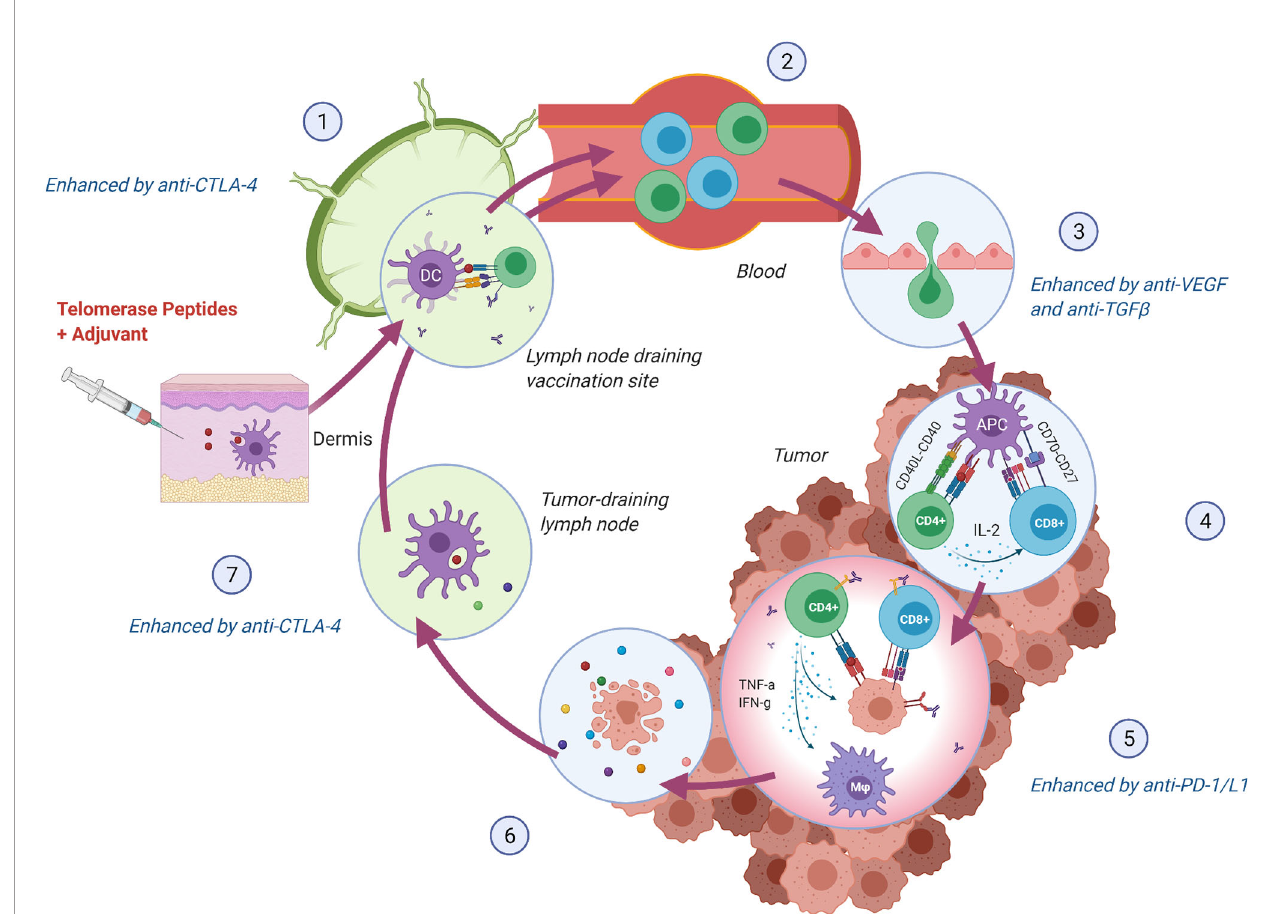
FIGURE 2 | hTERT speci fi c CD4+ Th1 cells support crucial steps in the Cancer Immunity Cycle (51). (1) Vaccine peptides are presented to naïve T cells by DCs in the lymph node draining the vaccination site. Anti-CTLA-4 monoclonal antibody (mAb) may lead to increased expansion of vaccine-induced T cells. (2) hTERT- speci fi c T cells enter circulation and (3) in fi ltrate the tumor. Normalization of the tumor vasculature through inhibition of VEGF may facilitate an increased in fl ux of T cells. (4) T cells recognize hTERT on local antigen-presenting cells in the context of an MHC class II molecule and directly stimulate local CD8+ T cells through IL-2 secretion and indirectly through co-stimulation of DCs (CD40L-CD40 interaction), leading to enhanced cross-presentation 44. (5) MHC class II expressing tumor cells can be directly killed through cytokine secretion or indirectly through activation of CD8+ cells and macrophages (M j ) (44, 48). Anti-PD-1/L1 mAb may provide increased effector activity of vaccine-induced T cells in the tumor by blocking regulatory signals on T cells (PD-1) or tumor cells (PD-L1). (6) Lysed tumor cells release hTERT or mutated peptides, which in turn are (7) phagocytosed by DCs and presented to T cells providing either intra- or intermolecular epitope spreading and broadening of the anti-tumor immune response (52). Anti-CTLA-4 mAb may, in turn, support further priming and expansion of anti-tumor T cells. Figure created with